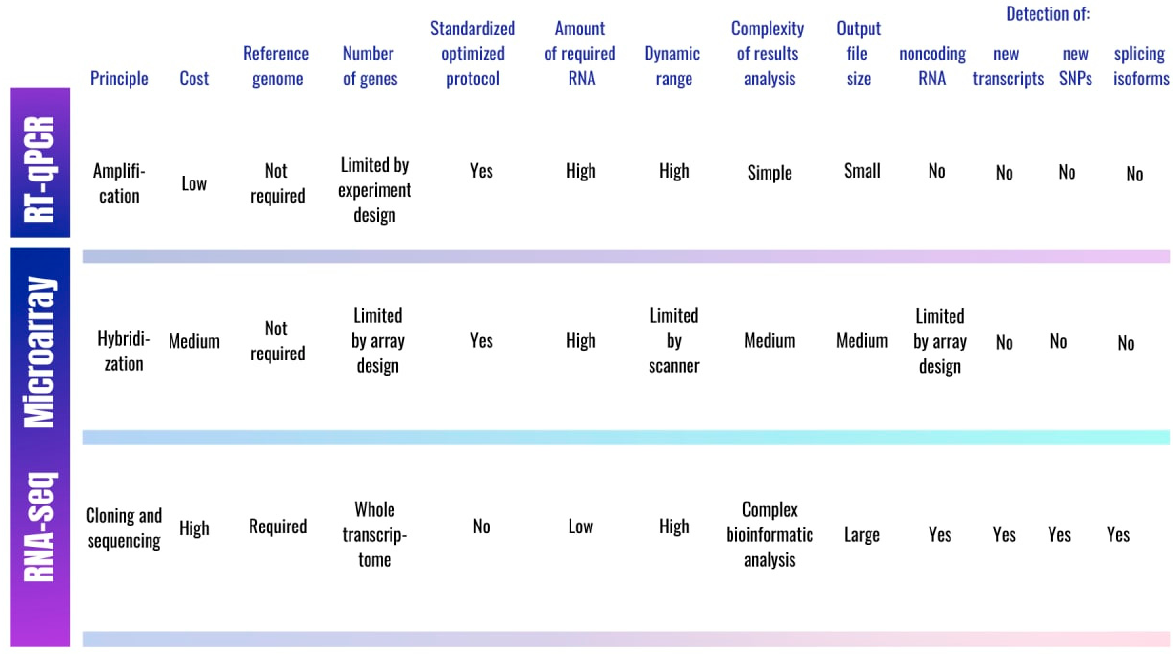
Figure 1. Comparison of approaches to gene expression analysis.